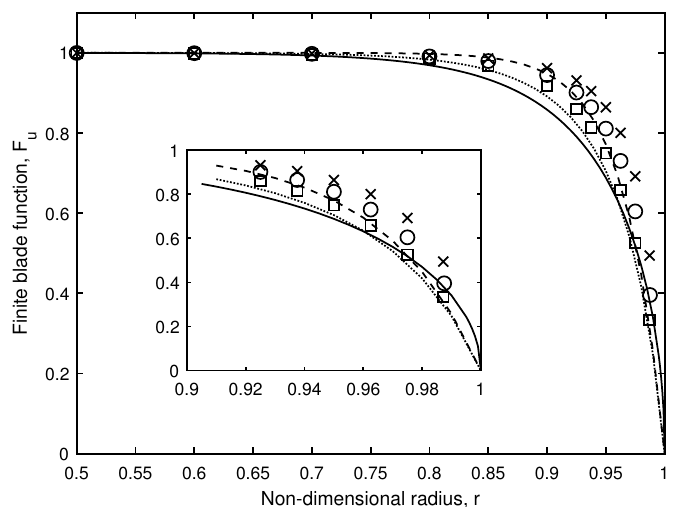
Figure 1. Axial finite blade function, F u for conditions in Table 1, p = 0.1. Solid line shows F P , dashed line is F u = F w from the Kawada-Hardin Equation ( ?? ), and dotted line, F u = F w from the modified pitch Equation (20). shows Biot-Savart calculation with Equation (12); , Biot-Savart calculation ⃝ × with Equation (17) and upper limit 1000 π ; □ Biot-Savart calculation with Equation (17) but upper limit = 2 π .